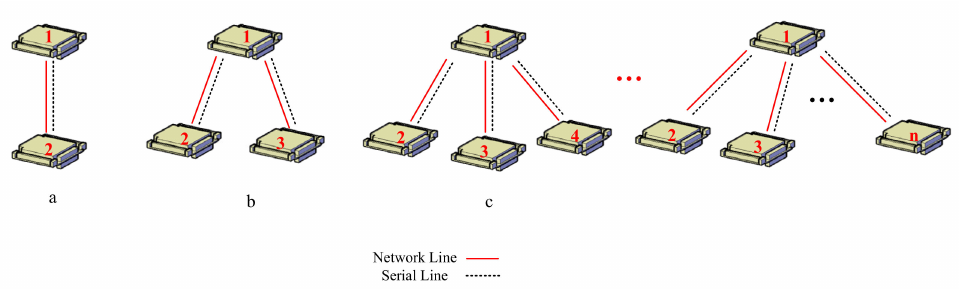
Figure 6. Model of a multi-CPU hot redundancy